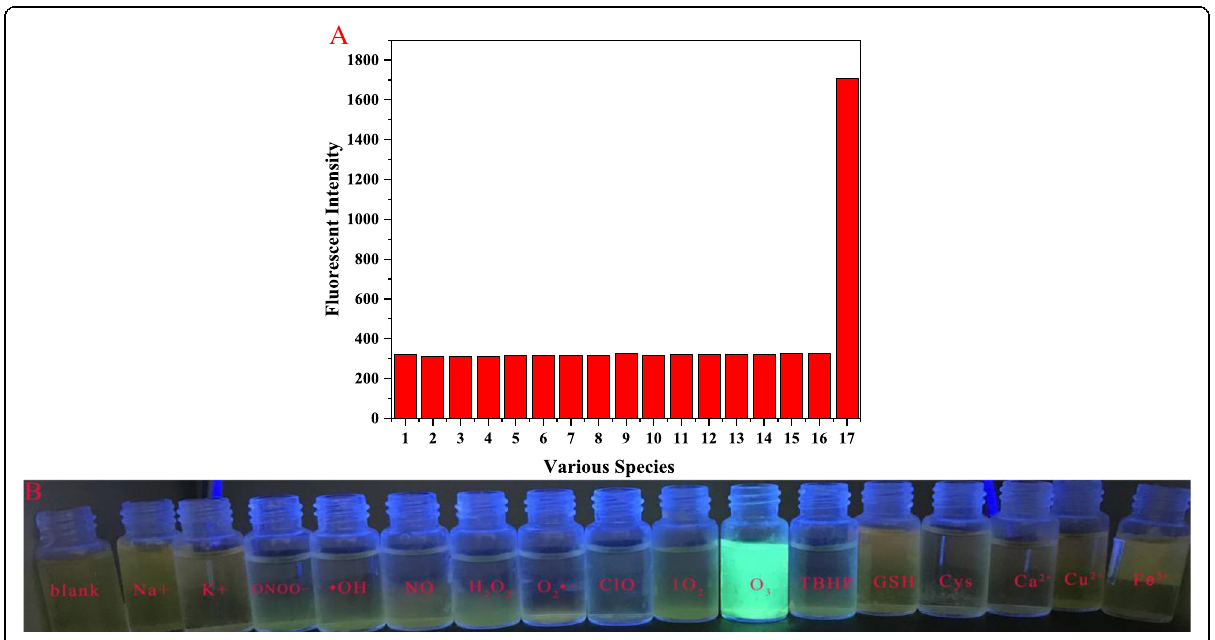
Fig. 6 a Fluorescence intensity change of the probe BCT (10 μ M) in PBS aqueous buffer (10mM, pH=7.4) after reacting with each analyte. b Probe BCT (10 μ M) at O 3 (1.0 equivalent) and other anions (10.0 equivalents) in PBS solution (pH=7.4, 10mM) under the ultraviolet light fluorescence